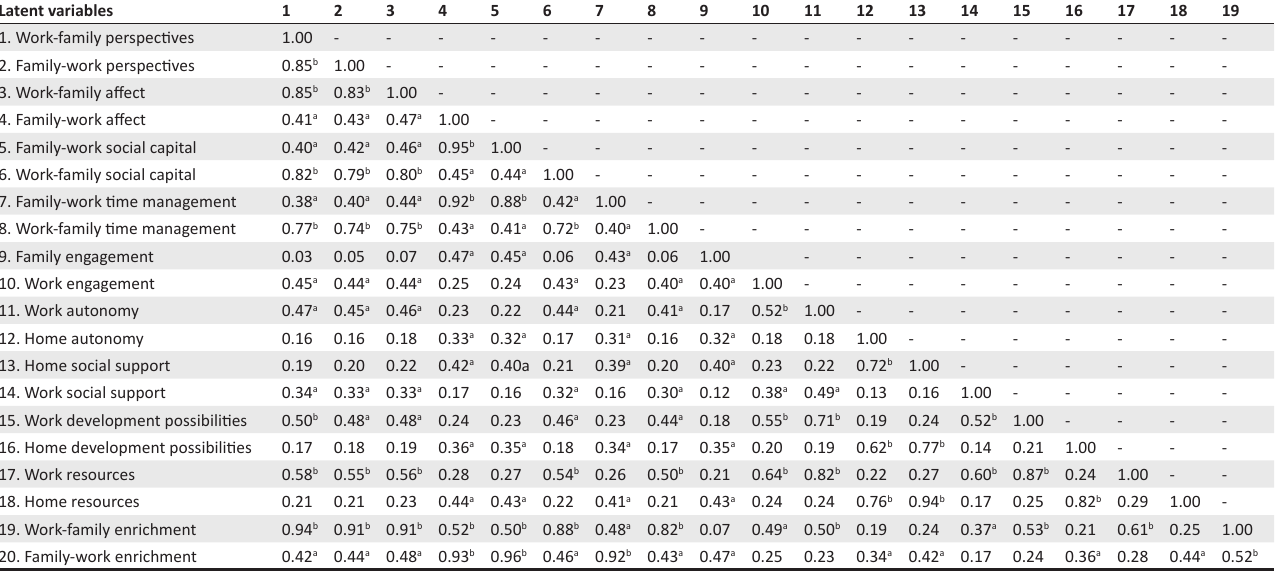
TABLE 2: Correlation matrix for the latent variables. Latent